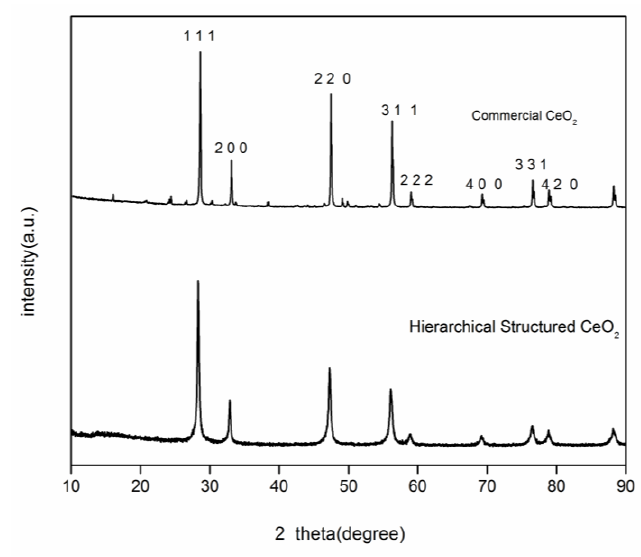
Figure 1. XRD pattern of as-prepared 3D hierarchical structured CeO 2 .